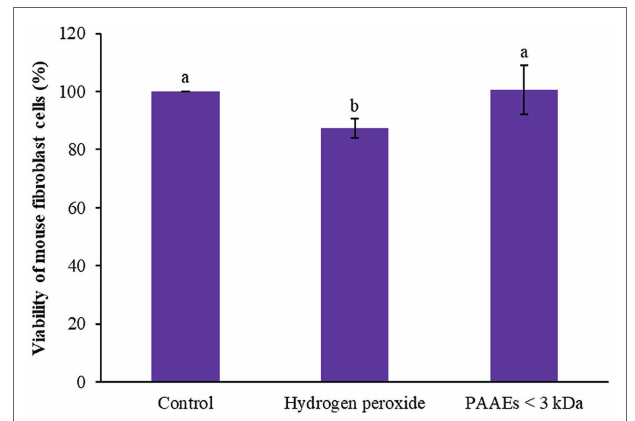
FIGURE 10 | Effect of PAAEs (MW <3 kDa, IC 50 value at 0.54 mg/ml) on the protective activity against oxidative stress-induced cells. The results were expressed as mean with SD of three replications from three independent studies. The letters above the bars denote significant difference ( p <